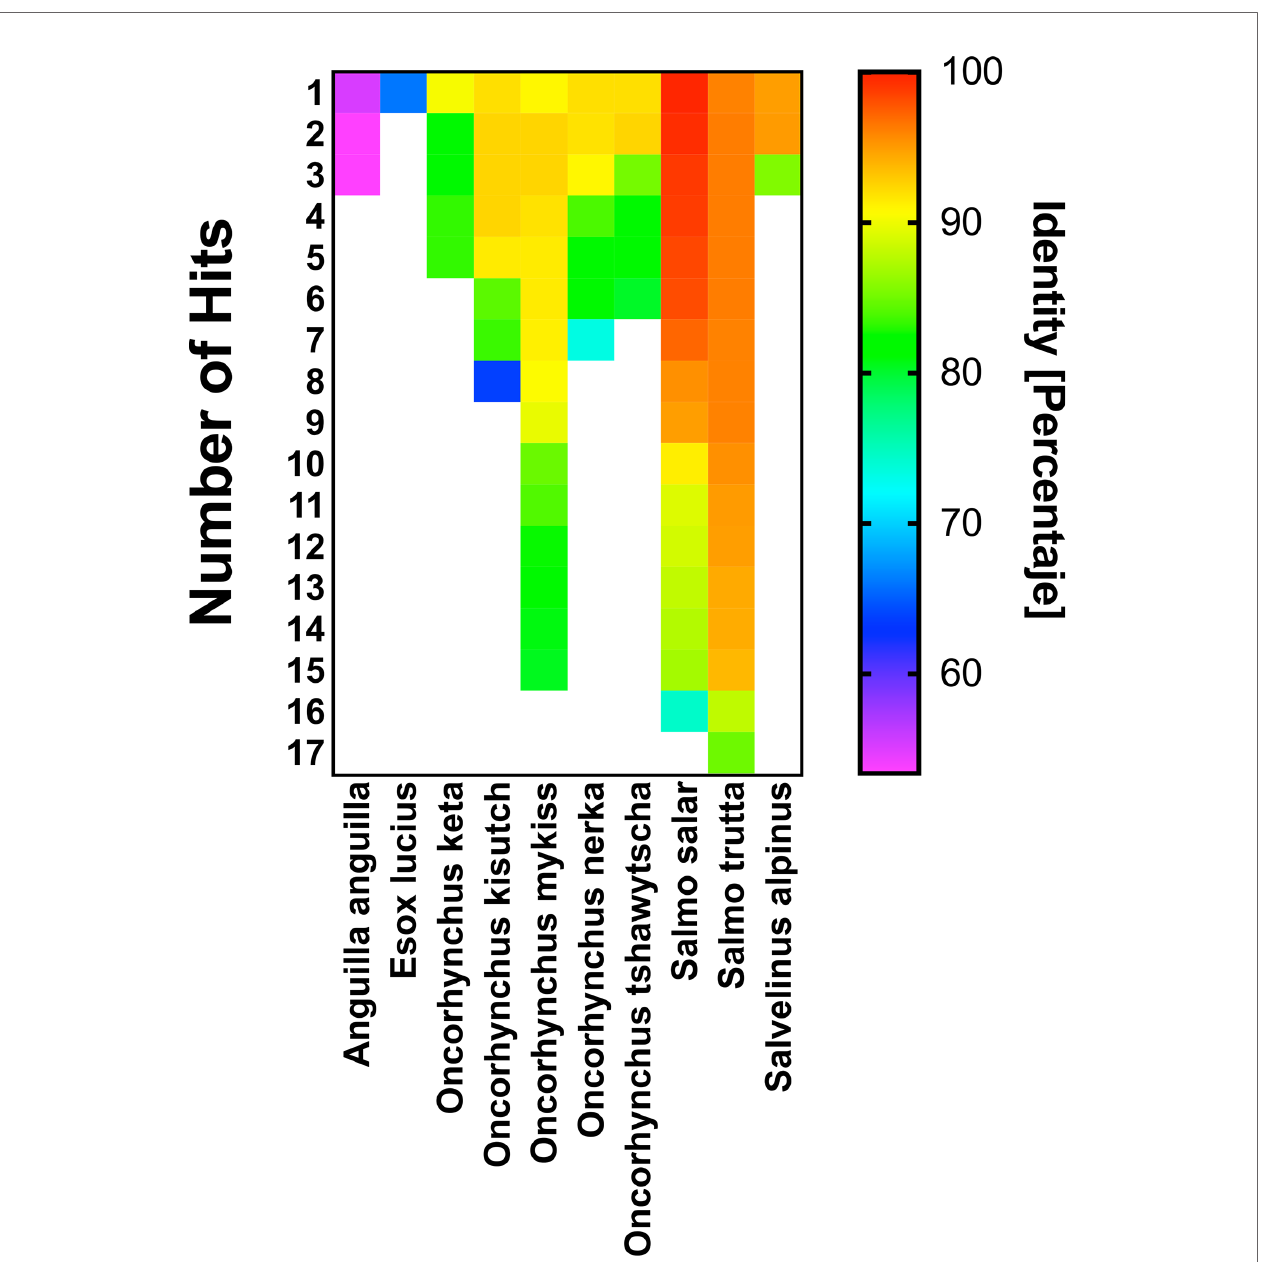
FIGURE 5 | Comparison of rIFN-Ia with interferons present in other Salmonids. The fi gure shows the percentage of identity of rIFN-Ia with interferons present in the salmonid species Salmo trutta , Salvelinus alpinus , Oncorhynchus nekra , Oncorhynchus mykiss , Oncorhynchus kisutch , Oncorhynchus keta , and in other fi sh (Eagle eel and Esox lucius). The fi gure shows the number of hits identi fi ed in each species and the percentage of identity. Both data were obtained by BLASTP alignment against database nr. The identity percentage is shown in a color scale and was constructed with the Prism 9.0